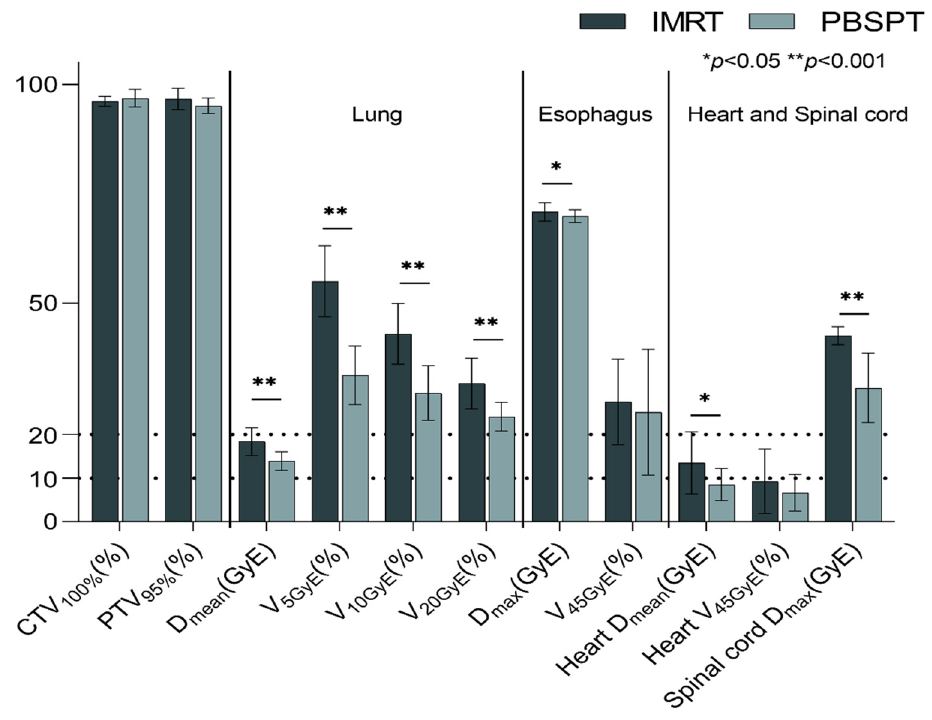
Figure 1. Dose–volume parameters for target volume and normal organs in patients treated with IMRT and PBSPT. Data are presented as the median, interquartile range. Abbreviations : IMRT, intensity-modulated radiation therapy; PBSPT, pencil beam scanning proton therapy; GyE, gray equivalent; CTV, clinical target volume; PTV, planning target volume; V XX% , volume receiving XX% of the prescription dose; V XXGyE , volume receiving more than XX Gy; D mean , mean dose; D max , maximum